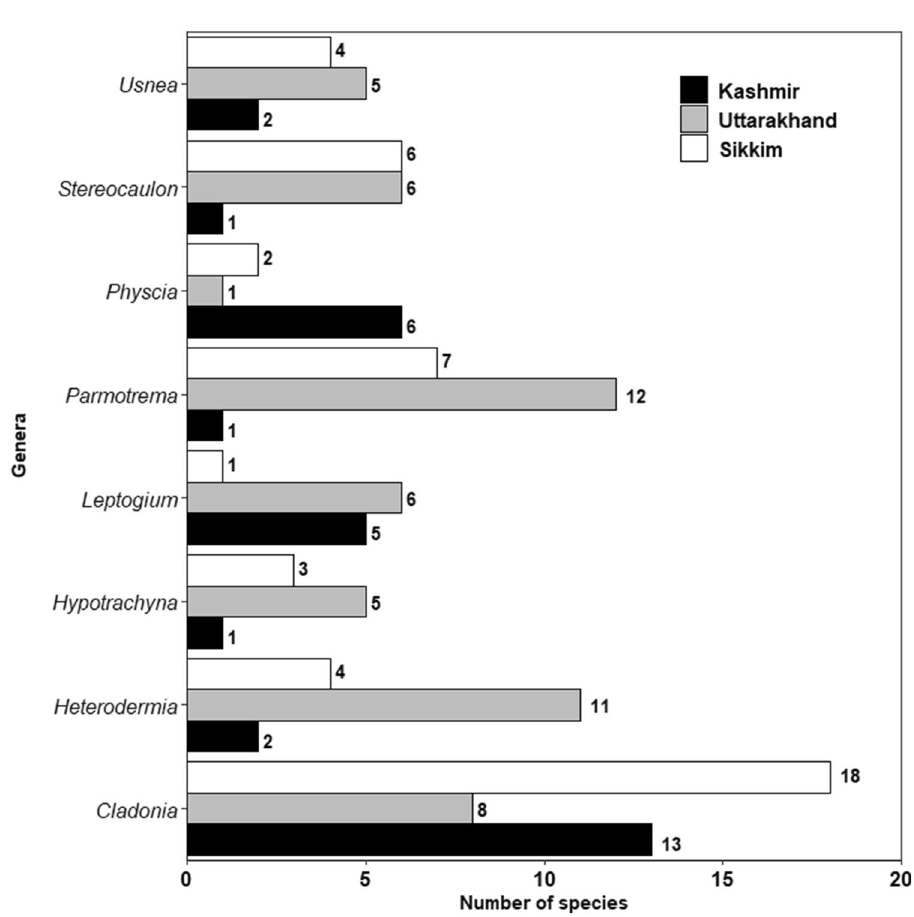
Figure 5. Eight dominant genera of macrolichens in Kashmir, Uttarakhand and